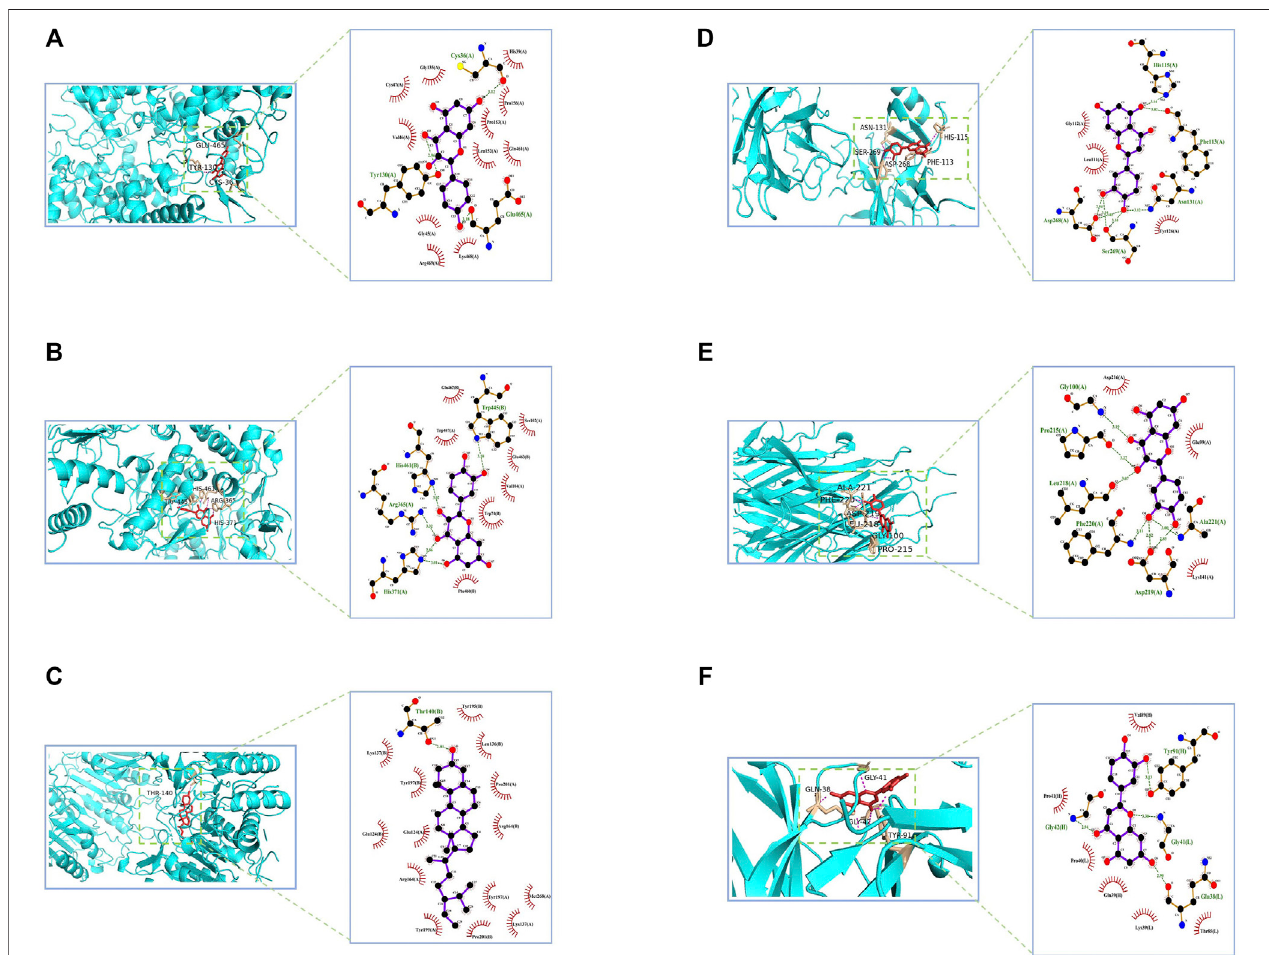
FIGURE 3 | CASP3, NOS3, VEGFA, TNF, PTGS2, and TP53 molecular docking diagram. Notes: PTGS2- kaempferol (A) NOS3- quercetin (B) CASP3- beta- sitosterol (C) TP53- luteolin (D) TNF- quercetin (E) VEGFA- luteolin (F)